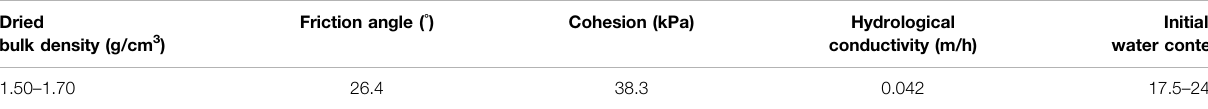
TABLE 2 | Parameter values of the materials.